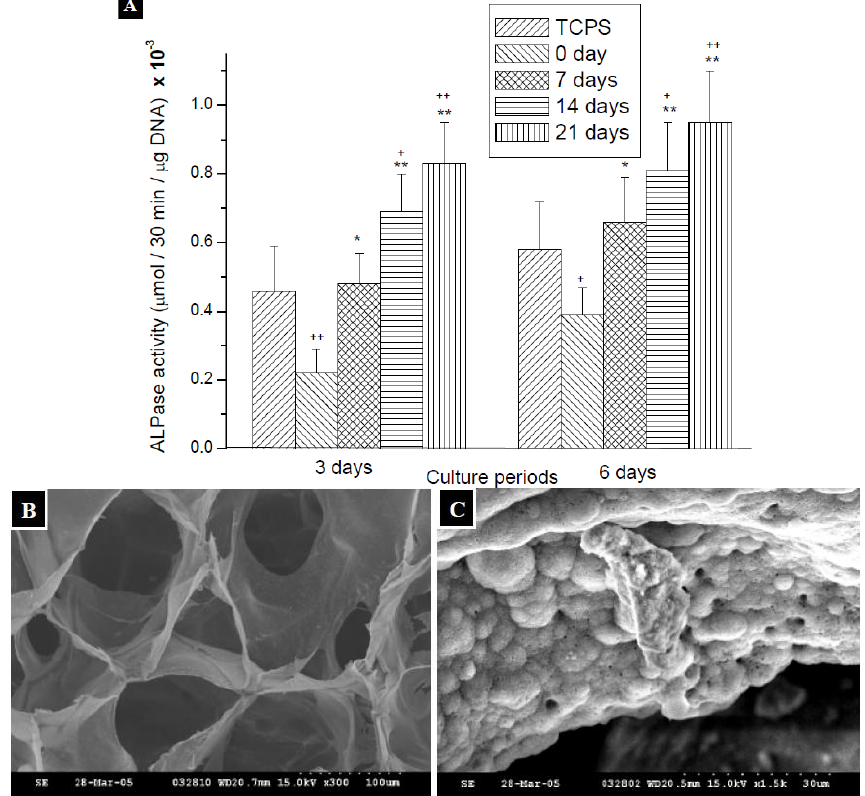
Figure 8. ( A ) The changes of ALPase activity in ROS cells cultured with TCPS and